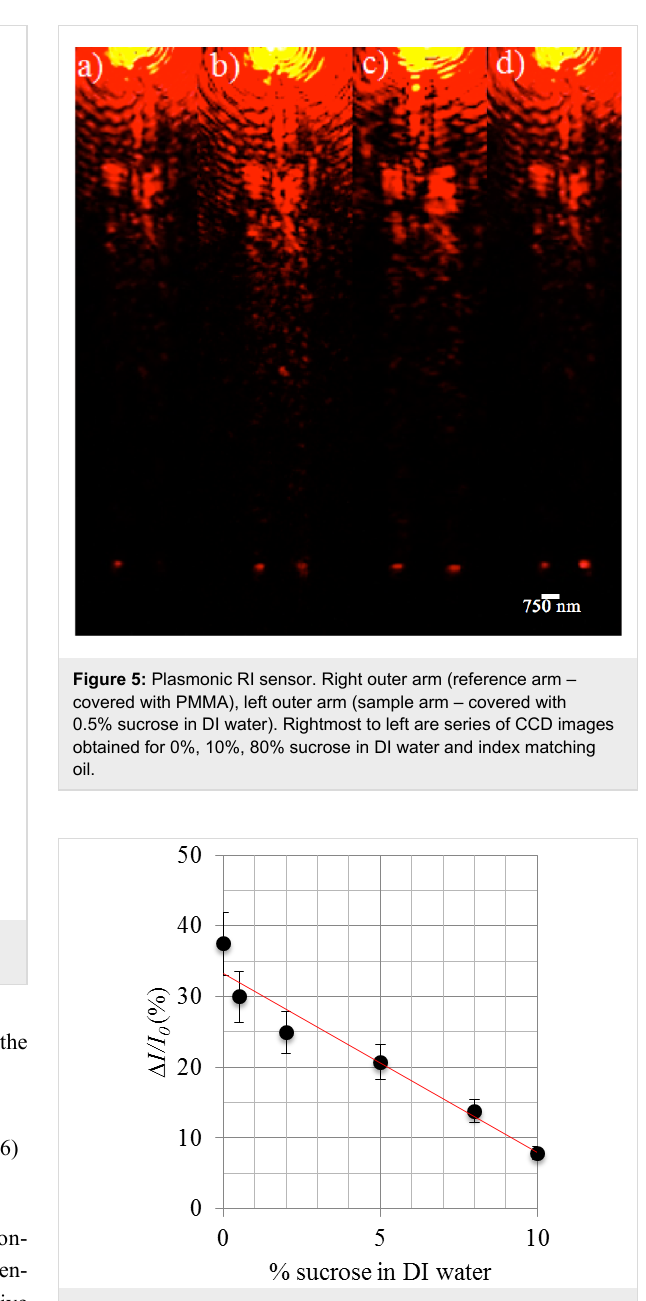
Figure 6: Relative intensity difference between the sample arm and reference arm versus weight percentage of sucrose in DI water. The error bars are for the standard